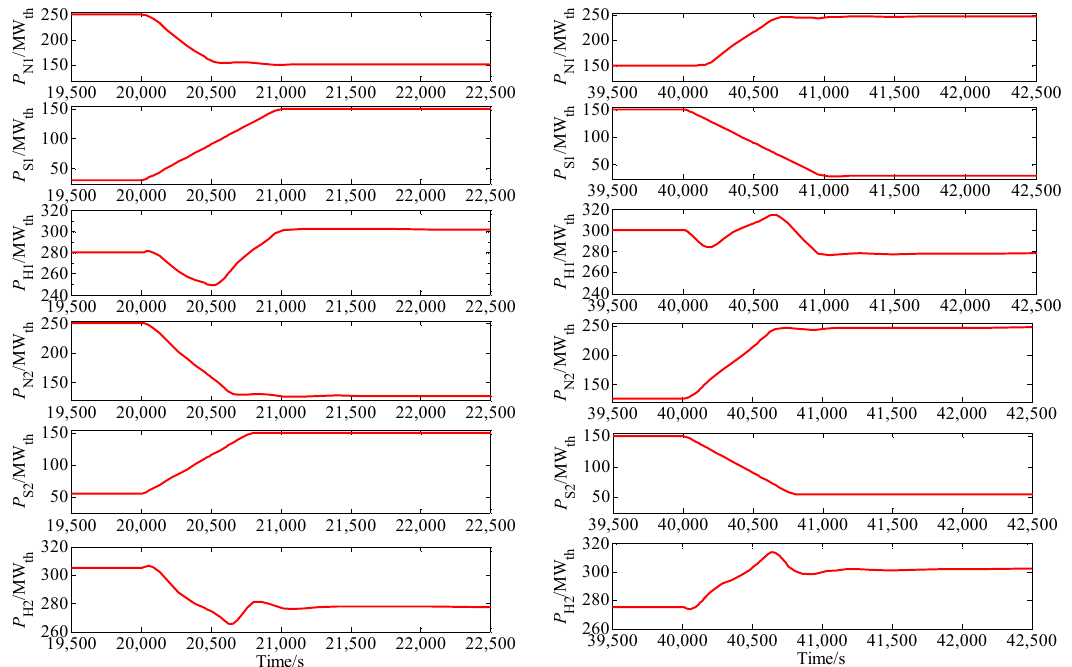
Figure 14. Responses of main steam pressure, feedwater header and branch resistances, P st : main steam pressure, H f1 and H f2 : header given by 1# and 2# feedwater pump, R i : fluid resistances in branch i ( i = 3, 4, 5).